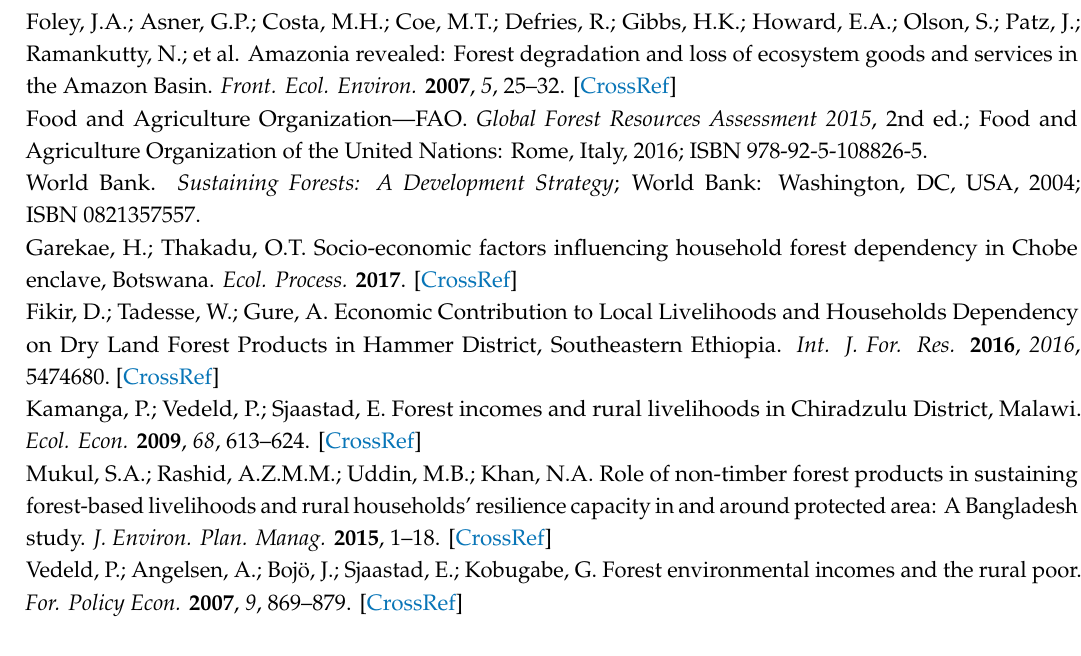
Table S1: Hypothesized e ff ects and references about the explanatory variables used in the regression models. Author Contributions: T.S. and N.M. performed the analysis and wrote the manuscript. T.O. and T.K. supervised and provided comments and suggestions for the research and reviewed the manuscript. All authors have read and agreed to the published version of the